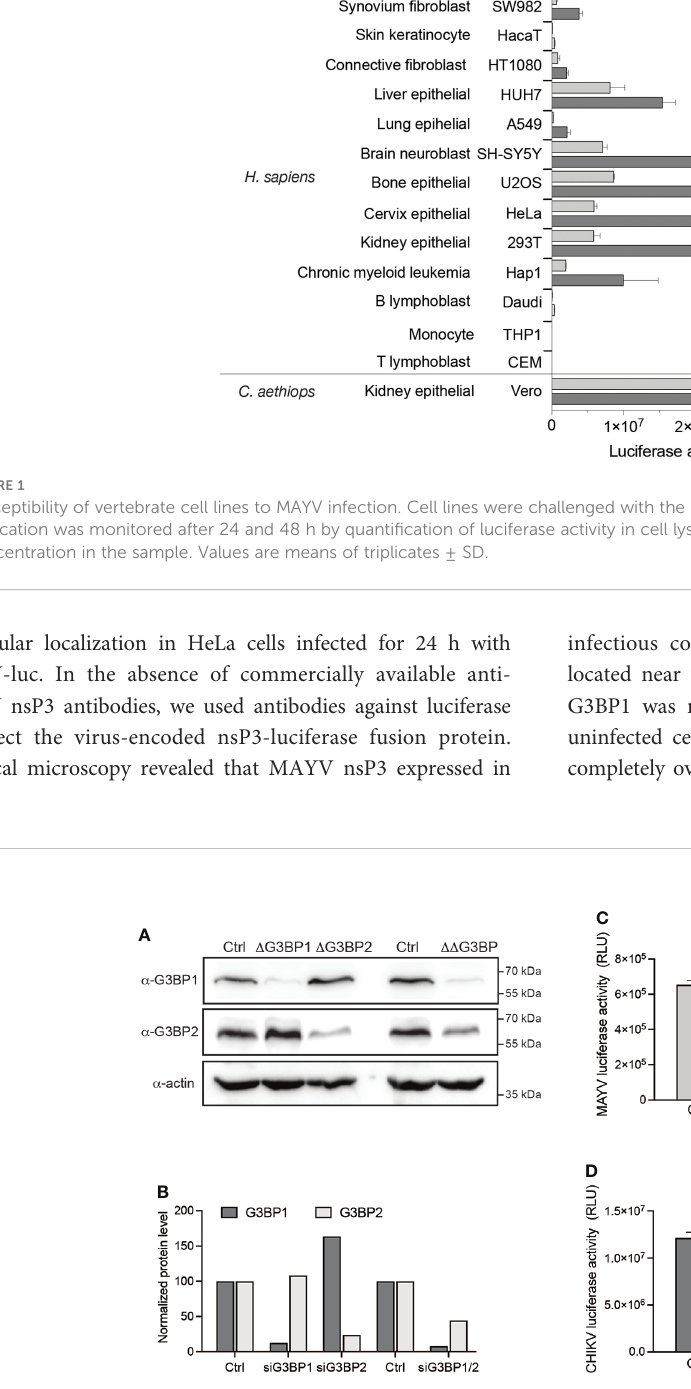
FIGURE 2 G3BP1 and G3BP2 are critical cofactors for MAYV replication. HeLa cells were transfected with nontargeting siRNA (Ctrl) or with siRNA targeting G3BP1 (siG3BP1), G3BP2 (siG3BP2), or both G3BP1 and G3BP2 (siG3BP1/2) as indicated. (A) After 48 h, cell lysates were separated by SDS-PAGE and probed for G3BP1, G3BP2, and actin. (B) Protein levels quanti fi ed from immunoblots using densitometry and normalized to actin levels were plotted. In parallel, the cells were infected with either (C) MAYV-luc or (D) CHIKV-nanoLuc viruses (MOI 0.1) for 24 h. Infection was monitored by quanti fi cation of luciferase activity in the cell lysates. Values were normalized according to protein content in the sample. Data are means of triplicates + SD and are representative of three independent experiments. ns, not signi fi